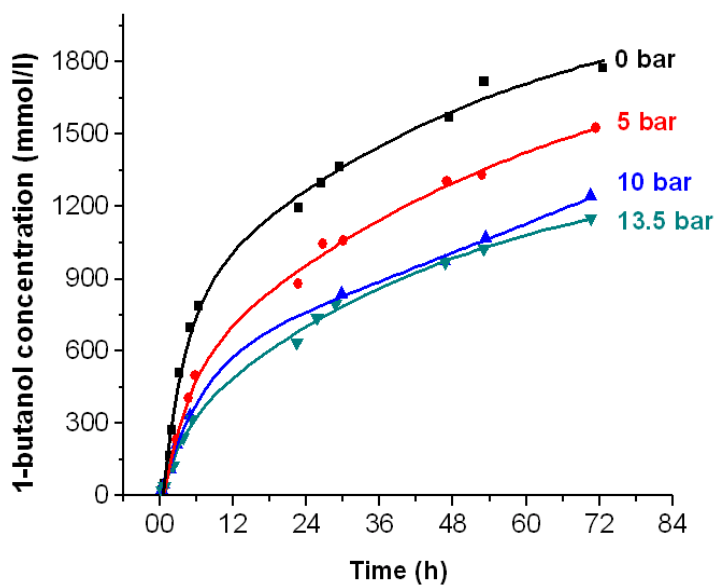
Figure 8. The effect of different initial hydrogen pressures to the forming amounts of 1-butanol.